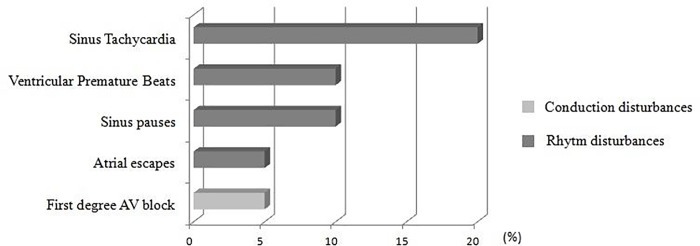
Chart showing the frequency of ECG changes in dogs with chronic Monocytic Ehrlichiosis over five minutes.